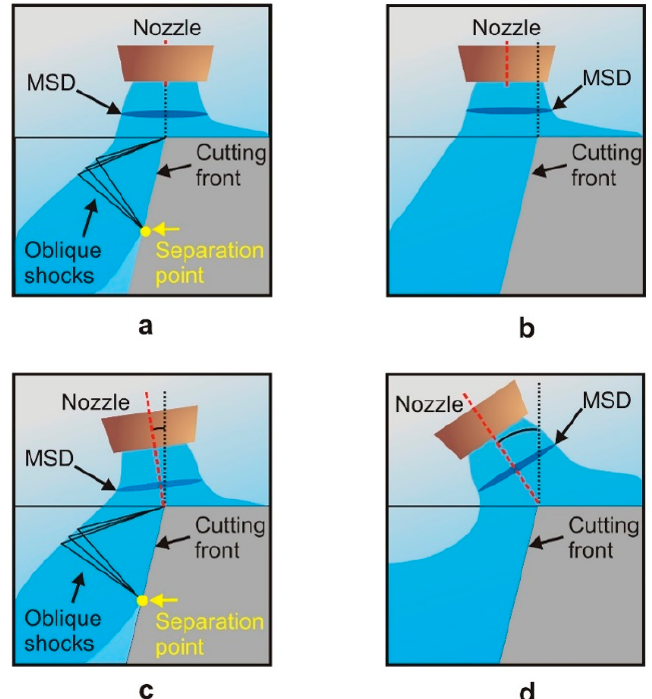
Figure 18. A schematic view of the aerodynamic interactions for ( a , b ) different nozzle positions, and ( c , d ) different nozzle tilt angles. The arrow in ( a ) and ( c ) denotes the boundary layer separation. Adapted with permission from [89]; Copyright 1997 AIP Publishing.